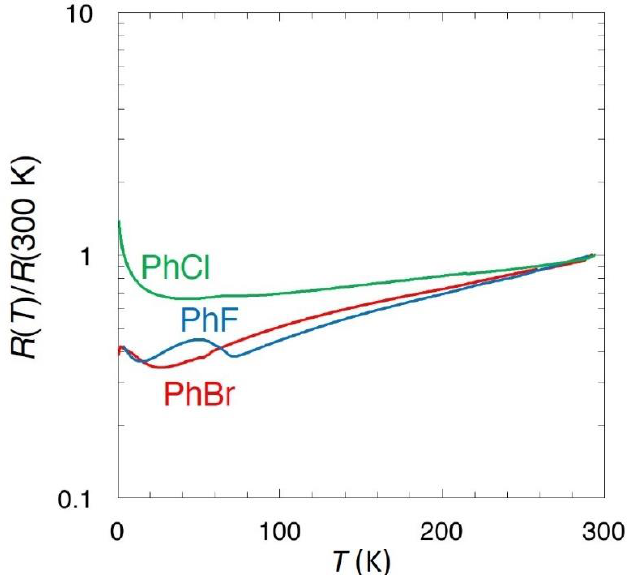
Figure 6. Electrical resistivity for β″-(BEDT-TTF) 4 (H 3 O)Ru(C 2 O 4 ) 3 · G where G = PhBr, PhCl, or PhF.